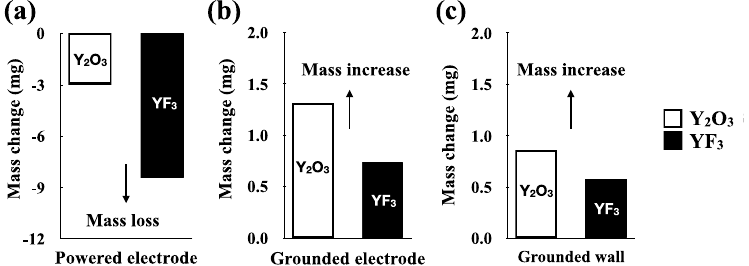
Figure 4. Mass changes owing to the NF 3 plasma etching: Y 2 O 3 and YF 3 coatings. ( a ) Y 2 O 3 and YF 3 after etching of the powered electrode; ( b ) Y 2 O 3 and YF 3 after etching of the grounded electrode; ( c ) Y 2 O 3 and YF 3 after etching of the grounded wall.